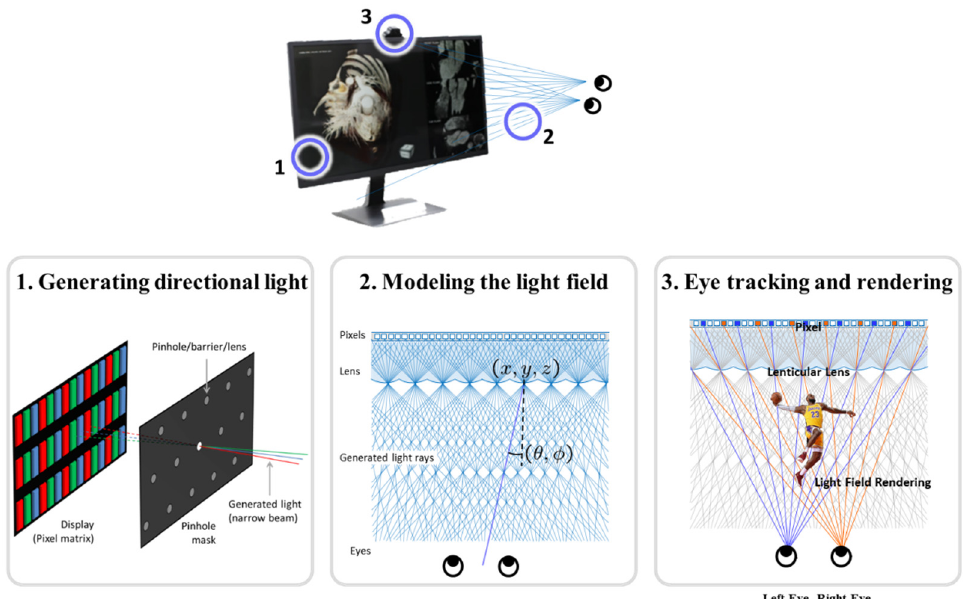
Figure 2. Autostereoscopic 3D display concept: (1) Directional light is generated by liquid crystal display (LCD) panels; (2) the 3D light field is modeled; and (3) 3D light rendering is performed according to user eye position, as determined by eye tracking algorithms.